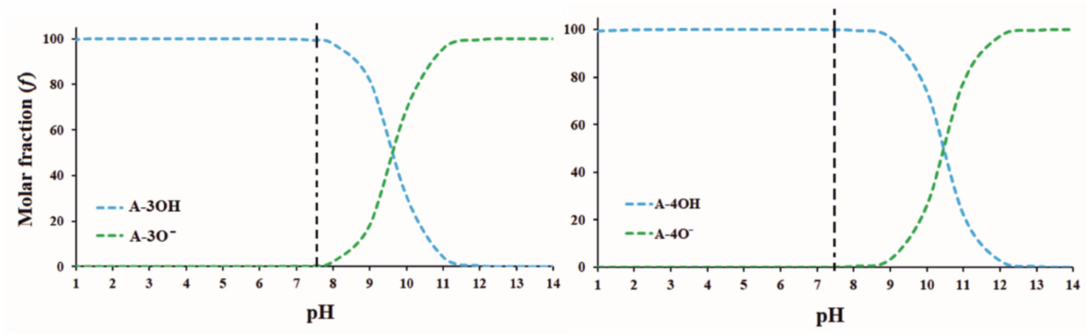
Figure 3. Graph of distribution of molar fraction (f) of acid–base forms of the investigated compounds at different pH values. Blackline represents physiological pH